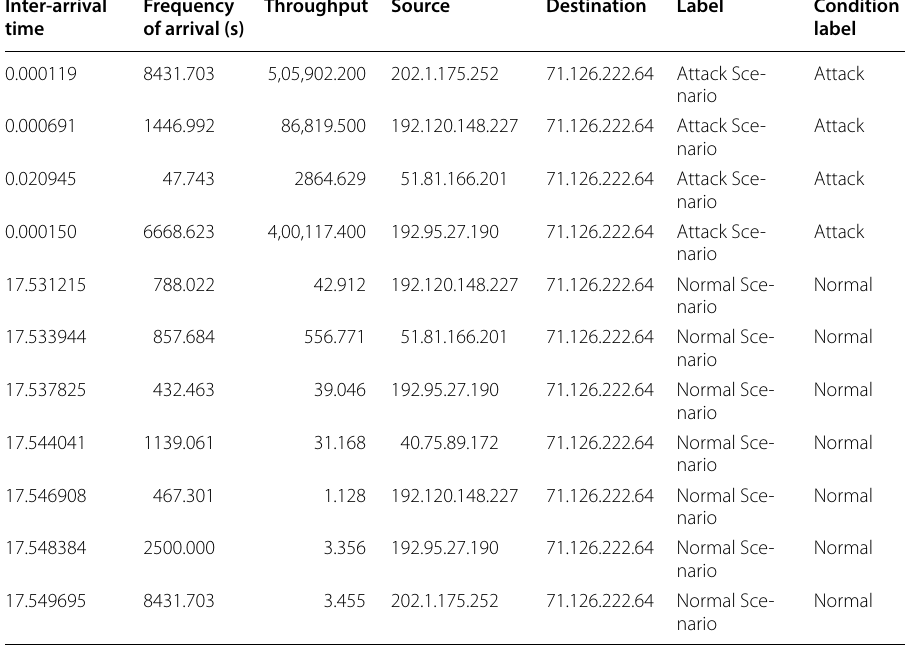
Table 5 Throughput analysis for attack and normal scenarios Inter-arrival Frequency Throughput time of arrival (s)